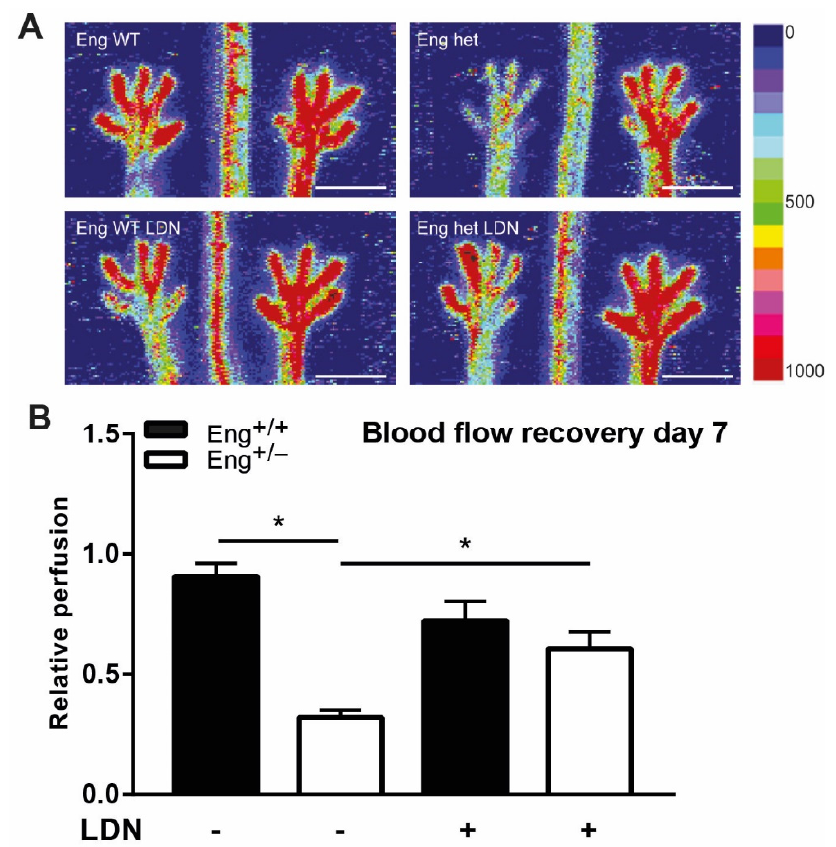
Figure 7. Hind limb blood flow recovery in female mice increases with LDN treatment. ( A ) Representative images of blood flow recovery in the paws as measured by laser Doppler perfusion imaging (LDPI), 7 days after HLI and subsequent treatment with LDN. Colors indicate the level of flow as indicated on the right panel of the figure. The left limb has HLI, the right limb was used as control. Scale bar: 1 cm ( B ) Quantification of LDPI measurements, N = 5–7 female mice per group. Black bars = WT, white bars = Eng+/ − . * p < 0.05.